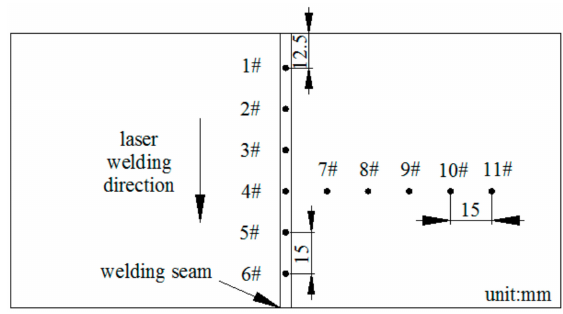
Figure 4. Surface morphology of ( a ) 304 stainless steel welding seaming and ( b ) Fe-Mn-Si SMAs welding seam.